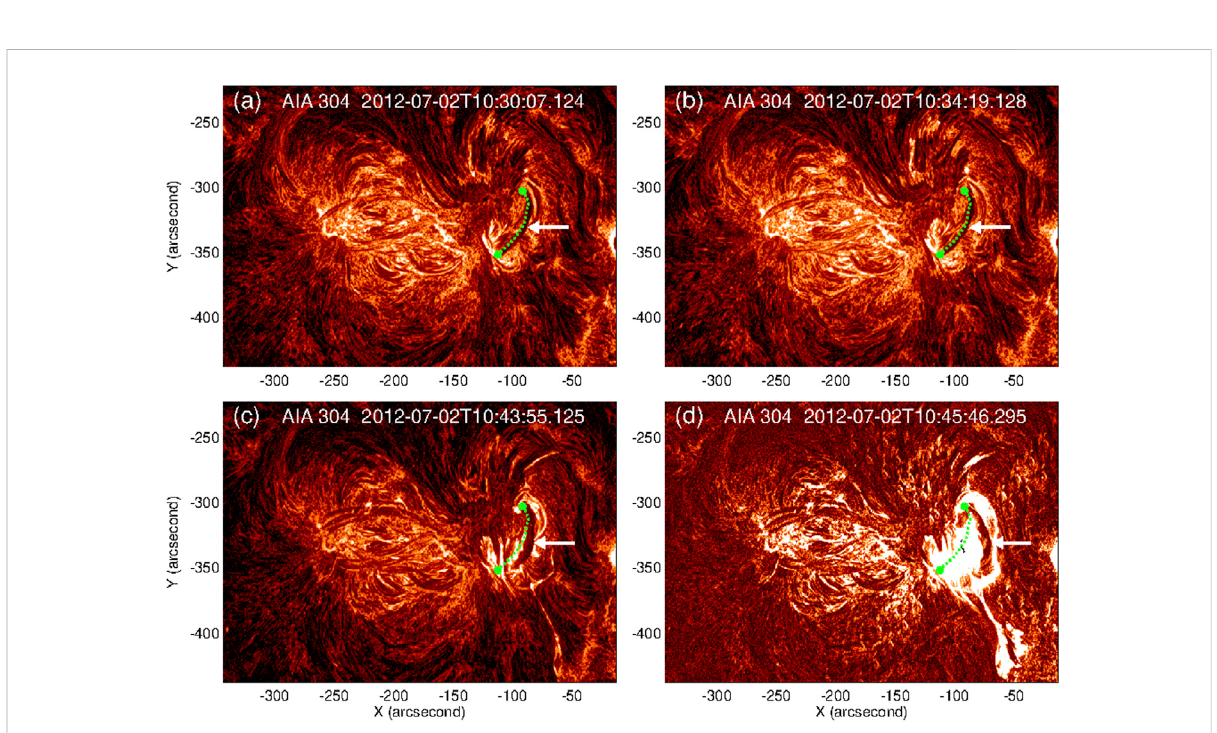
FIGURE 2 Panels (A – D) show the pre-existing fi lament and its subsequent evolution (marked by white arrows) in 304 Å. The green-dashed line marks the location of fi lament at 10:30 UT. Important is the activation of the fi lament around 10:43 UT (panel (C) ) and subsequent onset of fi lament eruption around 10:45 UT (panel (D)